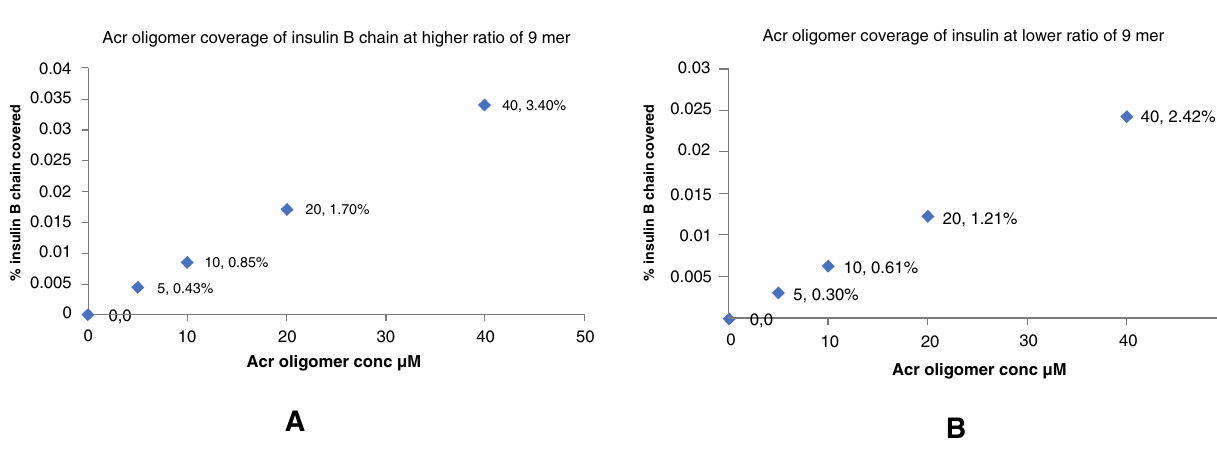
Figure 4. Simulation plots of Acr non gel filtered with different ratios of oligomer. ( a ) A plot of simulated Acr oligomer assuming 9-mer ratio of 60% and 10% of 10- to 12-mer versus percentage of molecules of insulin B chain covered at 118 µM. ( b ) A plot of simulated Acr oligomer assuming a 9-mer to 12-mer ratio of 20% versus the percentage of molecules of insulin B chain covered at 118 µM.